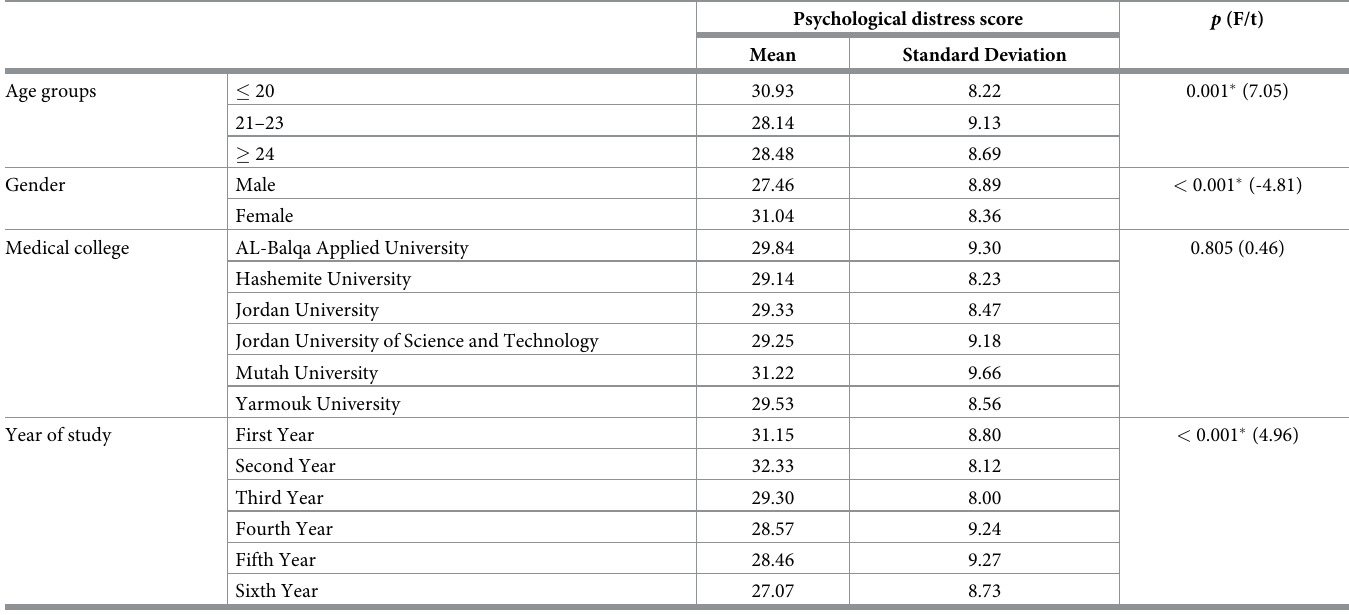
Table 6. Comparison of psychological distress scores among different groups of